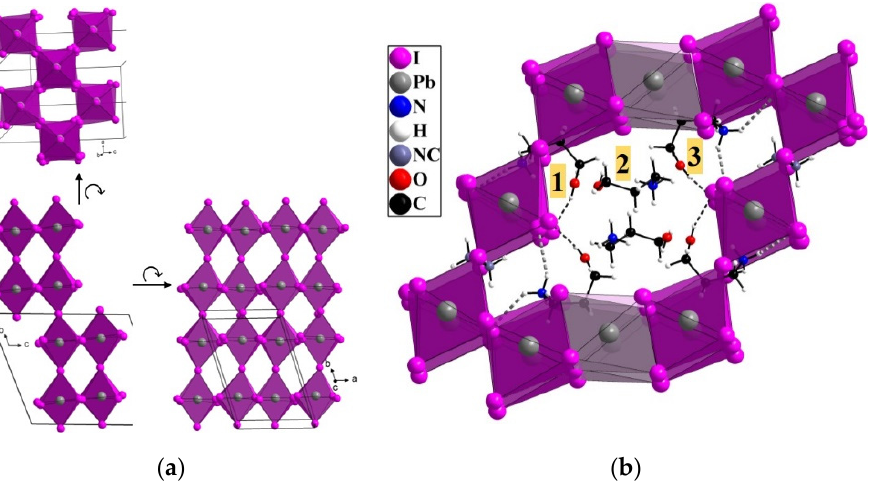
Figure 2. Structure of (HPA) 6 (MA)Pb 5 I 17 . ( a ) Partial view showing the 2D perovskite subnetwork along a , b , and c highlighting the corner-sharing connectivity; ( b ) partial view showing organic cations HPA + and MA + in channels defined by corner- and face-sharing PbI 6 octahedra, highlighting the three types of HPA + cations (numbered 1, 2, and 3) and hydrogen bonding (OH….I and NH….I contacts < 3.05 Å, dashed lines).